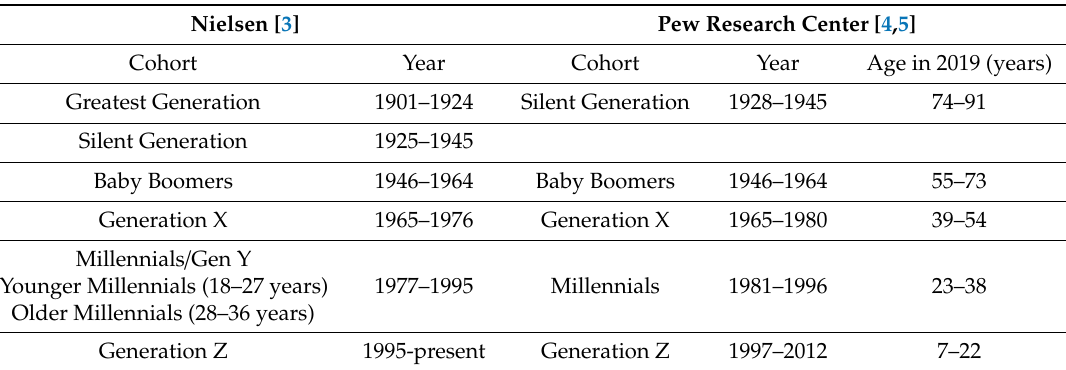
Table 1. Di ff erent cohorts of